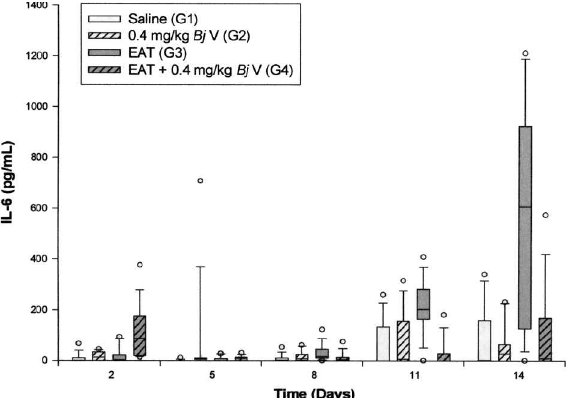
FIG. 3. Box plot of the IL-10 level kinetics in EAT cells treated with Bj V. Each box represents 25–75% values with the median as an internal line, the error bar represents 10% and 90%, and the circle represents the outliers. Statistics: 11th day, G3 > G1; p <